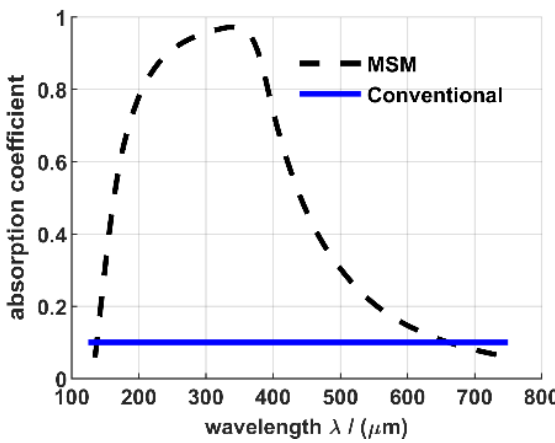
Figure 4. Absorption comparison of the two detectors.